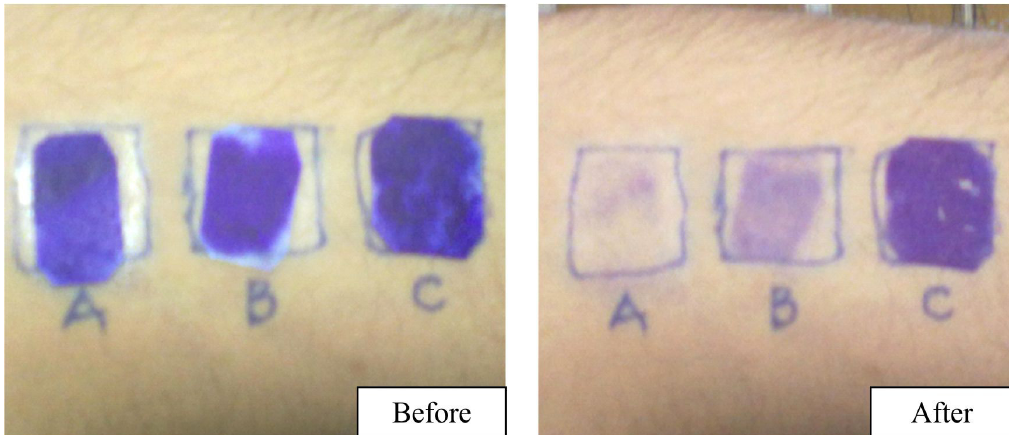
FIGURE 5 - Results of crystal violet stain test for the in vivo skin protection